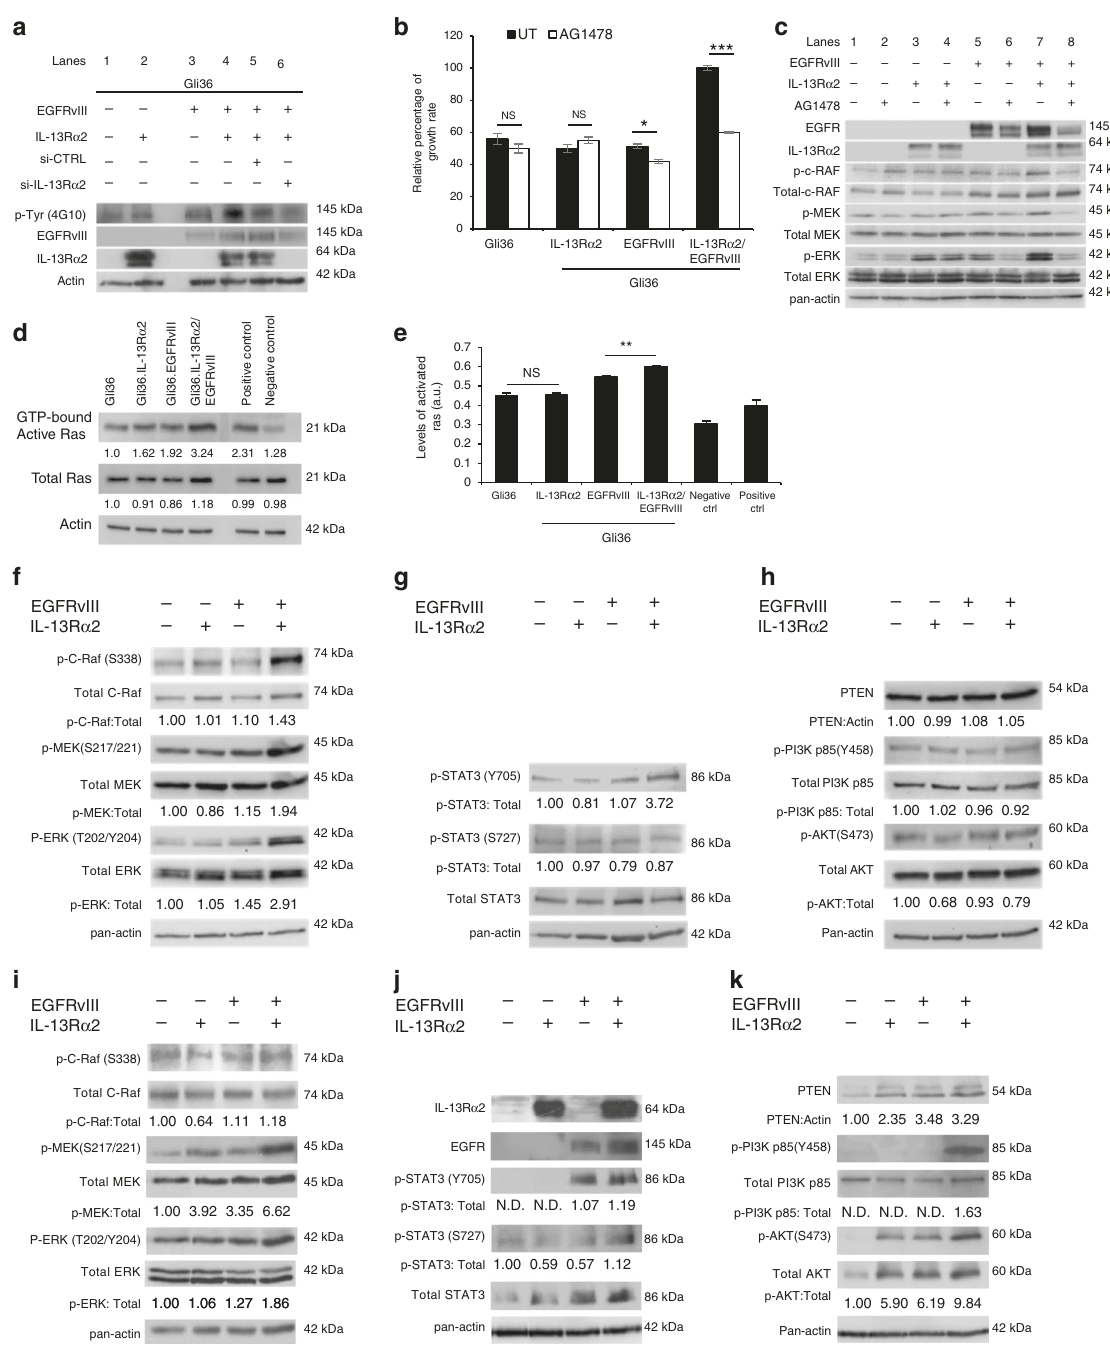
Fig. 4 Oncogenic signaling of IL-13R α 2 increases tyrosine kinase activities and promote cell proliferation through activation of the RAS/RAF/MEK/ERK signaling cascade. a Cell lysates from Gli36, Gli36.IL-13R α 2, Gli36.EGFRvIII, and Gli36.EGFRvIII/IL-13R α 2 post-knockdown with scrambled or IL- 13R α 2 siRNA were examined for the total levels of tyrosine phosphorylation using anti-phosphotyrosine antibodies. b CCK-8 proliferation assay was performed with and without 10 μ M AG1478 treatments. All data are represented as mean ± SEM. Unpaired t -test *** p < 0.001 c Endogenous expression levels of the RAS/RAF/MEK/ERK signaling were examined in the indicated cells with and without AG1478 treatment. RAS activation was determined by either d Raf-1 RBD agarose beads pull-down assay or e ELISA assay. Endogenous protein expression levels of f Total and p-C-RAF, Total and p-MEK/p-ERK g Total and p-STAT3 h PTEN, total and p-PI3K p85 α and total and p-AKT were examined in the indicated cells. Normal human astrocytes transfected with EGFRvIII, IL-13R α 2 or co-expressing both receptors were examined for endogenous expression levels of i Total and p-C-RAF, Total and p-MEK/p-ERK, j Total and p-STAT3, k PTEN, total and p-PI3K p85 α and total and p-AKT. For all immunoblots, pan-actin served as internal loading controls, and band densitometry quanti fi cations for the proteins were performed using ImageJ (NIH). The value derived from densitometry quanti fi cation is obtained from normalizing each of the signaling proteins against actin in a single experiment, and presented as a ratio of phosphorylate form over total protein. Each of these was performed at least two independent